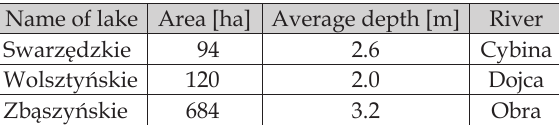
Table. 1. Morphometric data of the lakes